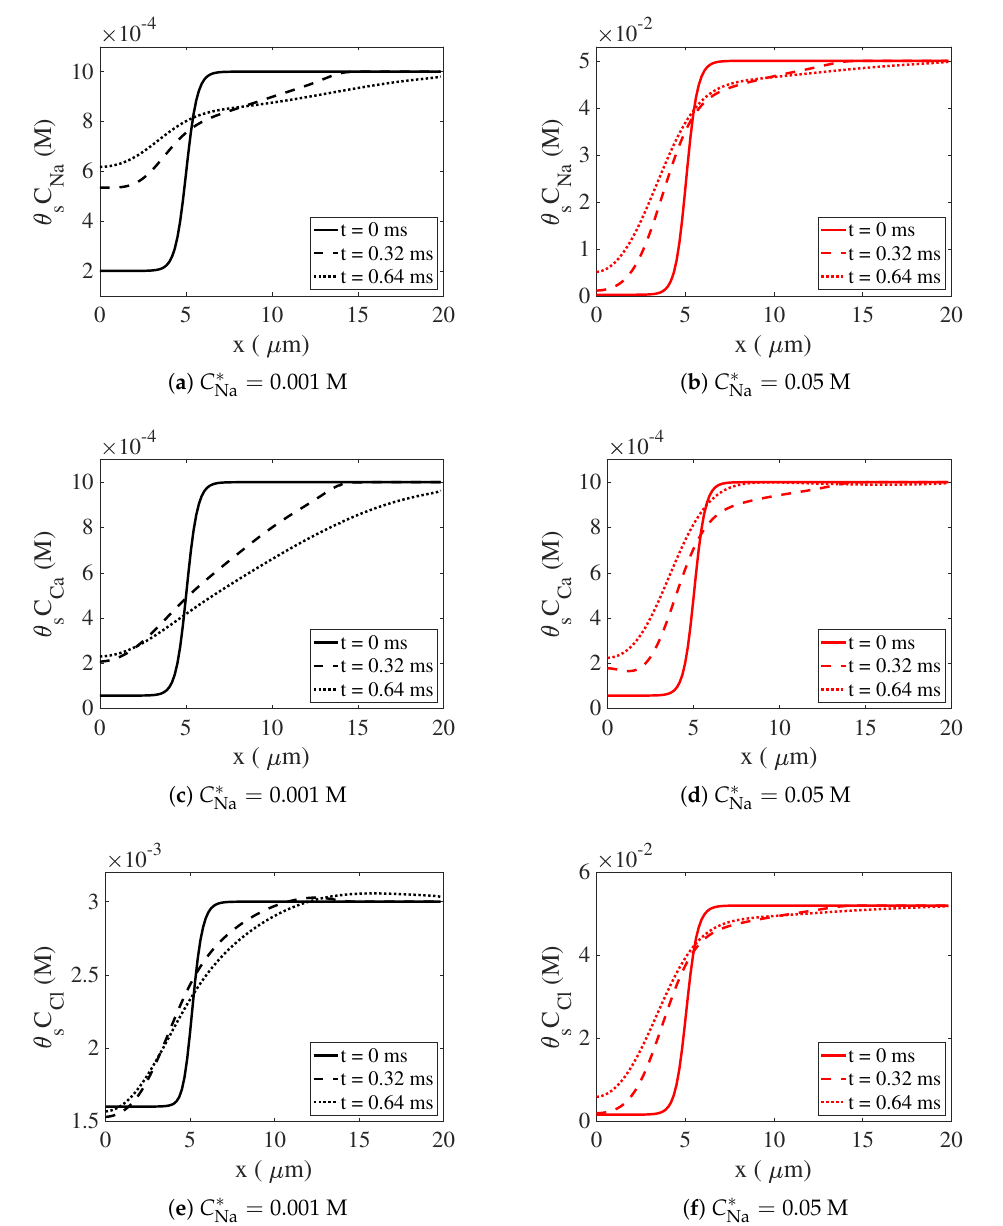
= 0.001 M and ( b , d , f ) Na